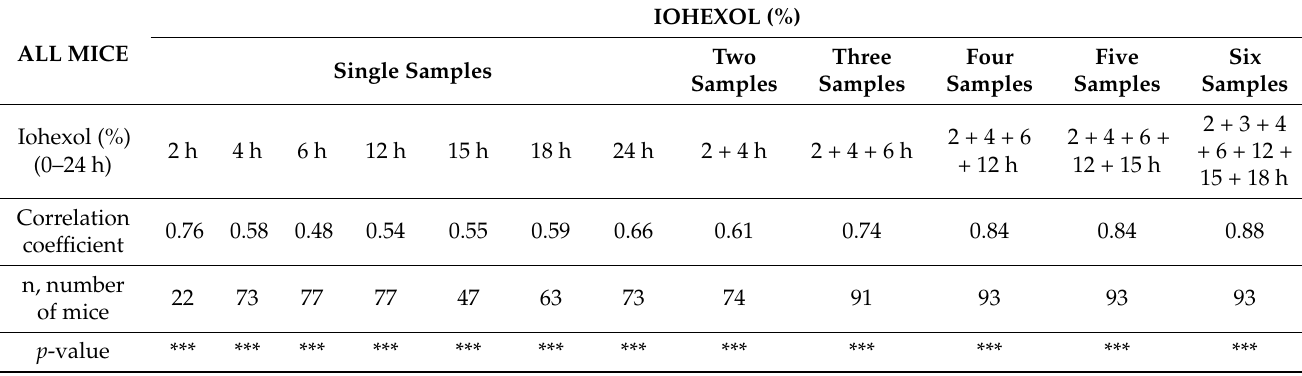
Table 2. Correlation coefficients between the urinary excretion of iohexol in both the seven individual and the cumulative urinary collection samples, collected during 24 h after the oral administration of iohexol to control (W1 and W7; total n = 22) and treated (W2, W4 and W5; total n = 71) female and male